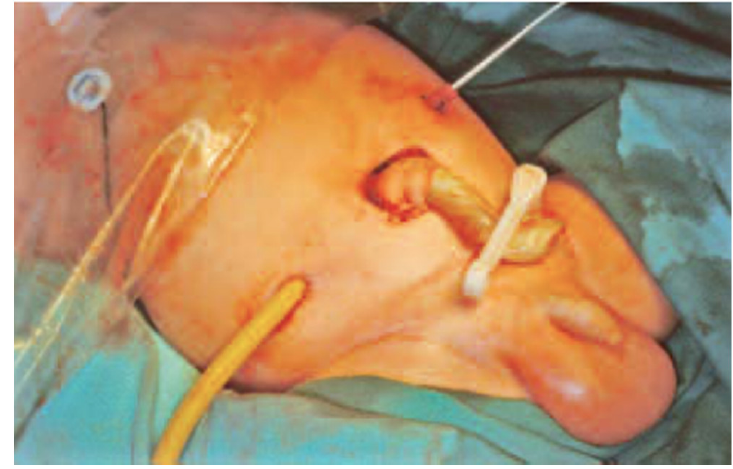
Figure 2. Representative photograph of a patient with tube stoma. The bowel is sutured to the peritoneum at the point of entry of the tube.